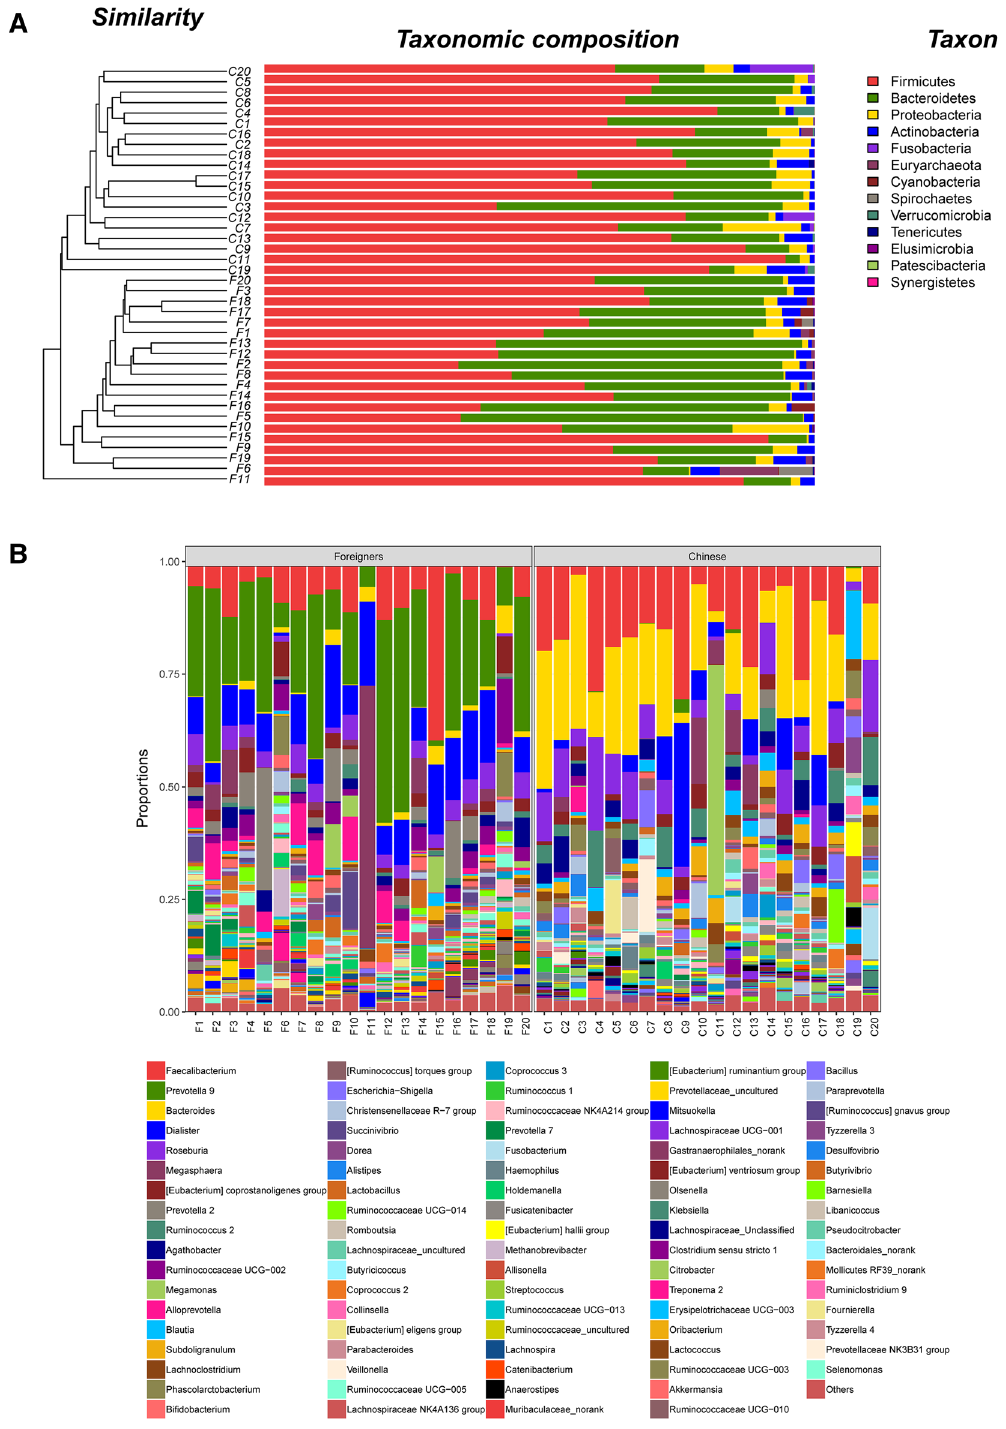
Figure 3. Composition of fecal microbiota at the phylum and genus levels. ( A ) Hierarchical clustering of fecal microbiota at the phylum level. Each line and bar represents one sample. ( B ) Composition of fecal microbiota at the genus level. Each column represents one sample and each color represents one